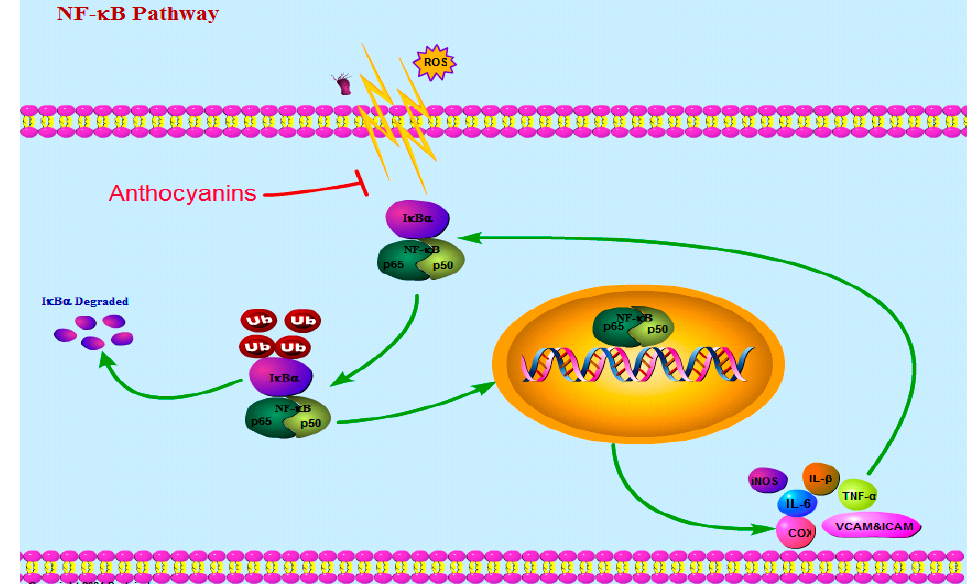
Figure 2. Anthocyanins reduce external stimulation and inhibit the activation of NF- κ B signaling pathway. (Ub: ubiquitination) pathway. (Ub: